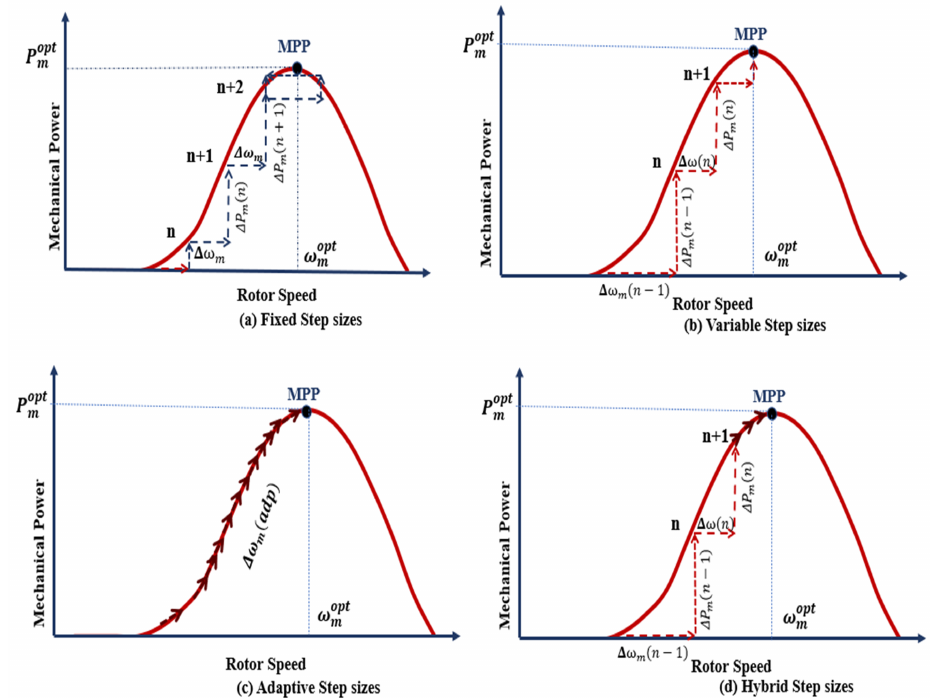
Figure 16. P&O algorithm-based types of step sizes generated. Reused with permission from Ref. [3]. Copyright 2021